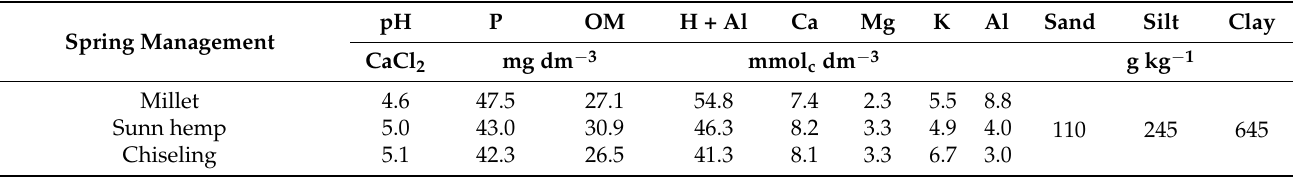
pH: active acidity; P: exchangeable phosphorus; OM: organic matter; H + Al: potential acidity ; Ca: exchangeable calcium; Mg: exchangeable magnesium; K: exchangeable potassium; Al: exchangea-